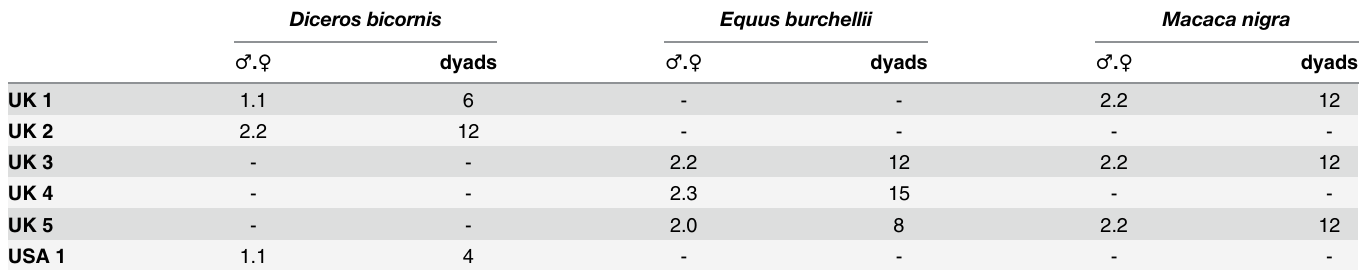
Table 1. Division of species at the different institutions showing numbers of males and females ( ♂ . ♀ ) and the number of keeper-animal dyads recorded (number of keepers x number of animals